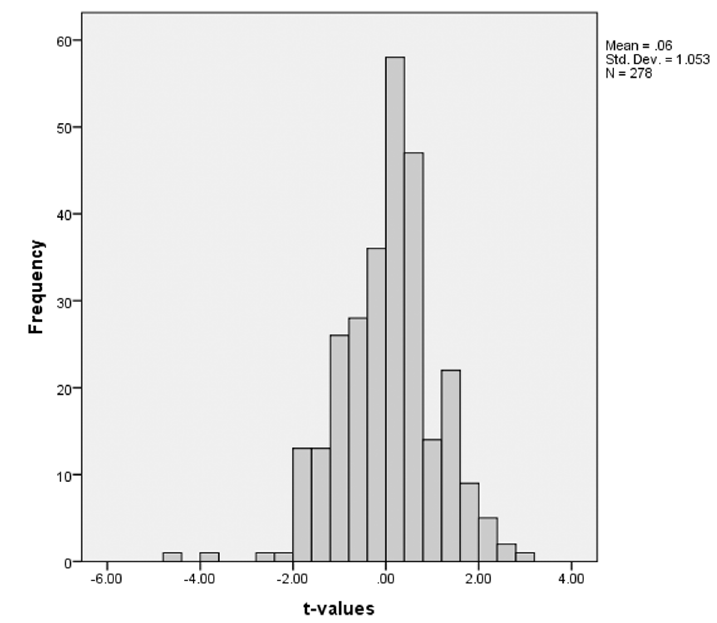
Figure 2. Distribution of t-values